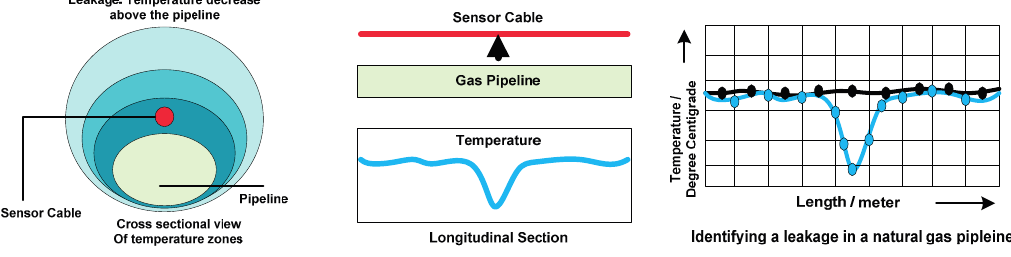
Figure 10. Optical fiber-based leakage detection